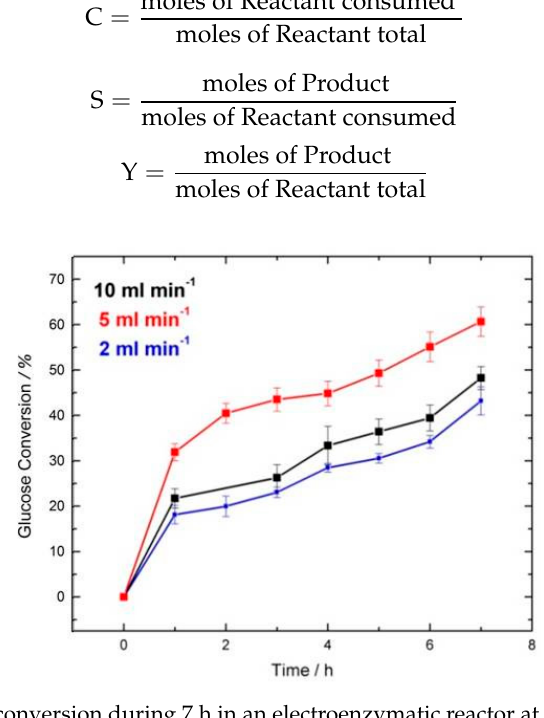
Figure 2. Glucose conversion during 7 h in an electroenzymatic reactor at different flow rates.